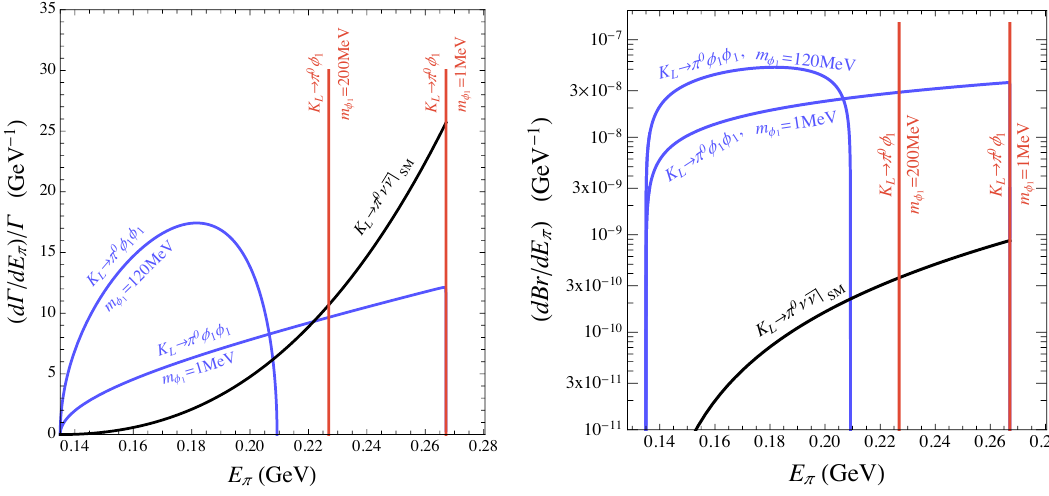
Figure 1 . Left: the normalized decay width distributions as functions of the pion energy, E (cid:25) , for (cid:25) 0 (cid:30) 1 , the SM (black line), for the decay dominated by the two body NP transition (Model 1), K L ! for two choices of invisible scalar masses, m (cid:30) = 1 MeV, 200 MeV (red lines) and for three body NP 1 (cid:25) 0 (cid:30) 1 (cid:30) 1 , with m (cid:30) decay (Model 2), K L = 1 MeV, 120 MeV (blue lines). Right: the branching 1 ! ratio distributions, where NP contributions saturate the present KOTO bound [9]. At the kinematic m (cid:25) , we have d (cid:0) SM p 3 dE (cid:25) while for NP Model 2 d (cid:0) p (cid:25) dE (cid:25) , where endpoint, E (cid:25) K L ! (cid:25) 0 (cid:30) 1 (cid:30) 1 / (cid:25) ! / p (cid:25) = ( E 2 m 2 p (cid:25) dE (cid:25) unless the Yukawa ) 1 = 2 (similarly for Model 3, section 5, d (cid:0) K L ! (cid:25) 0 1 (cid:22) 1 (cid:24) (cid:25) (cid:0) (cid:25) p 2 l +1 couplings y ij are purely real). This follows from the partial wave expansion, d (cid:0) =dE (cid:25) , (cid:25) (cid:24) (cid:25)(cid:23) (cid:22) (cid:23) rate the V - A SM interaction induces a negligible S - adapted to EFTs [22]. In the K ! wave contribution proportional to the neutrino mass, whereas the scalar interactions in our model (cid:12) E (cid:25) induce a non-suppressed S -wave. The maximum recoil, E (cid:25) , in contrast, is (cid:12) max !